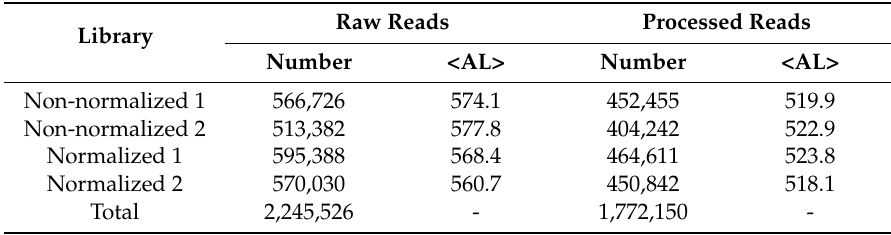
Table 1. Summary statistics of the 454 sequence data preprocessing step.